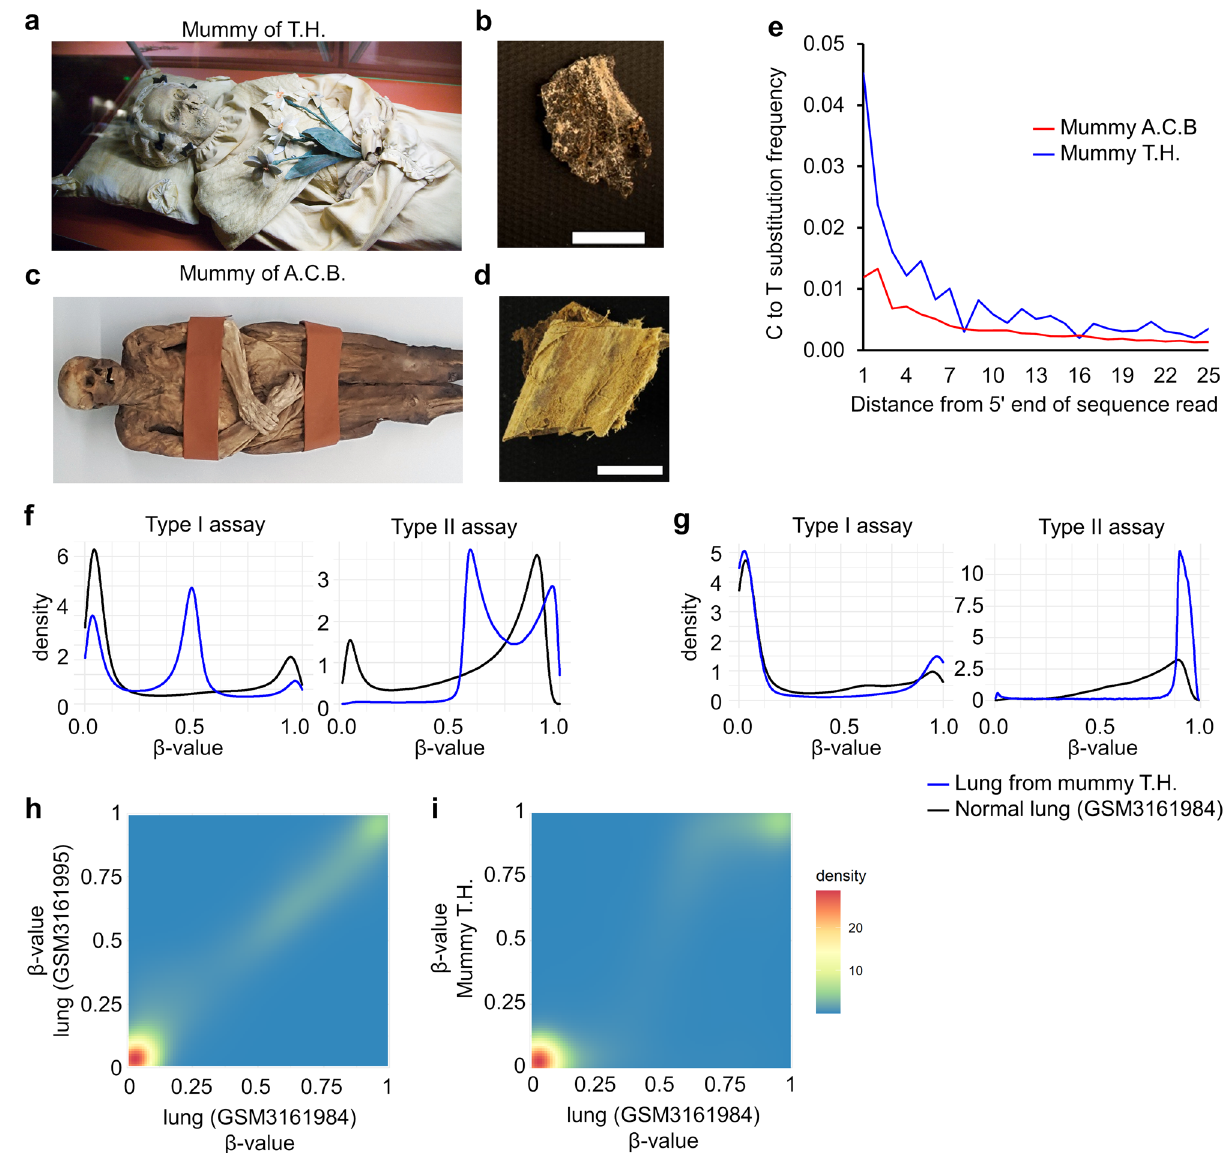
Figure 1. DNA methylation analysis in human remains. ( a ) Mummified human remains and ( b ) lung tissue sample of Terézia Hausmann (1769–1797); and ( c ) the remains and ( d ) gut tissue specimen of Anna Catharina Bischoff (A.C.B; 1719–1787); Size bar = 1 cm. ( e ) Frequency of specific base substitutions of cytosines into thymidine at the 5 ′ -ends of sequencing reads. Both DNA samples display increased frequencies of C to T substitutions close to the ends of DNA fragments, which is characteristic of ancient DNA. ( f ) Density plots of DNAm levels of the T.H. sample (β-value) across all Type I and Type II assays represented by the Illumina EPIC BeadChip (after normalization with ssNoob). ( g ) Density plots of 23,875 CpGs in Type I assays and 42,161 CpGs in Type II assays that passed the quality filter criteria (SeSAMe: P < 0.01). ( h ) 2-D density plots comparing DNAm levels in the same 23,875 filtered Type I assays between two present day lung tissue samples (Pearson correlation = 0.98); and ( i ) between a present-day lung-tissue sample and the profile of the specimen of T.H. (Pearson correlation = 0.94, CpGs on allosomes and SNPs were